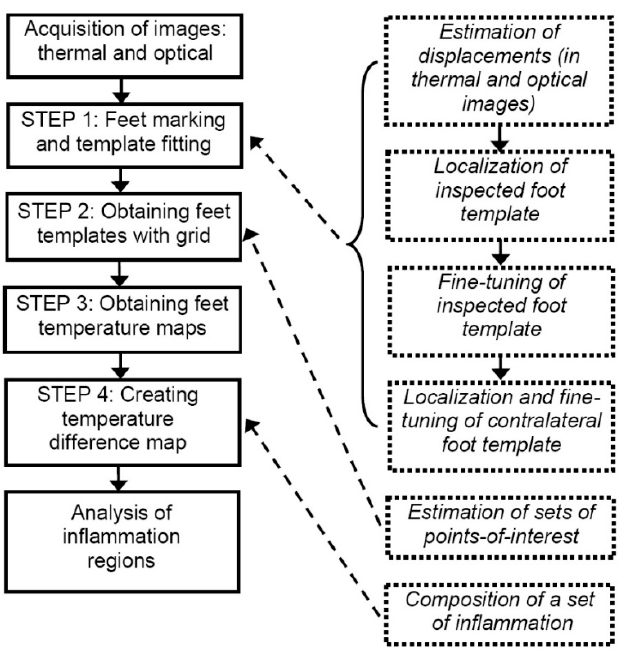
Figure 4. The block diagram of algorithm.